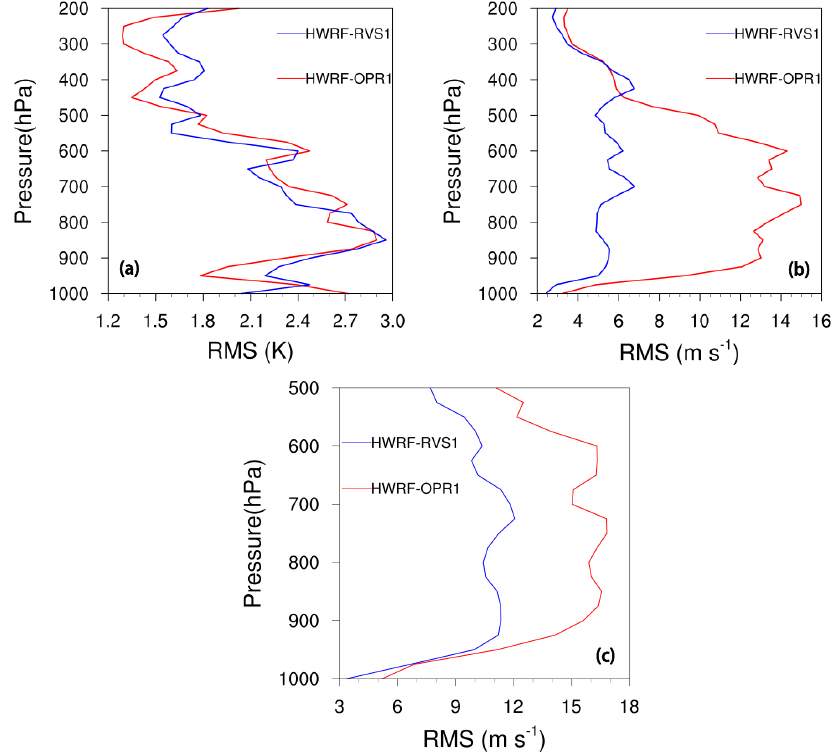
Figure 4. The root-mean-square (RMS) fit of the analysis to in situ observations within d02 region (Table 1) averaged over the data assimilation period from 1800 UTC 02 to 1800 UTC 03 October 2015 for ( a ) temperature and ( b ) wind as a function of pressure. ( c ) the RMS fit of the analyzed wind to in situ observations within d03 from 1000 hPa to 500 hPa during the data assimilation period from 1800 UTC 02 to 1800 UTC 03 October 2015. Red lines indicate the results from HWRF-OPR1, and blue lines indicate the results from